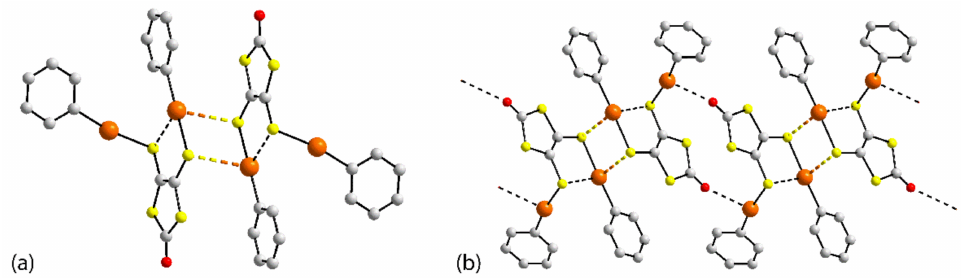
Figure 7. Supramolecular association in a zero-dimensional aggregate: 29 , ( a ) featuring a { ··· HgS} 2 synthon and ( b ) forming a supramolecular chain in 29 via additional Hg ··· O secondary-bonding interactions (black dashed lines).